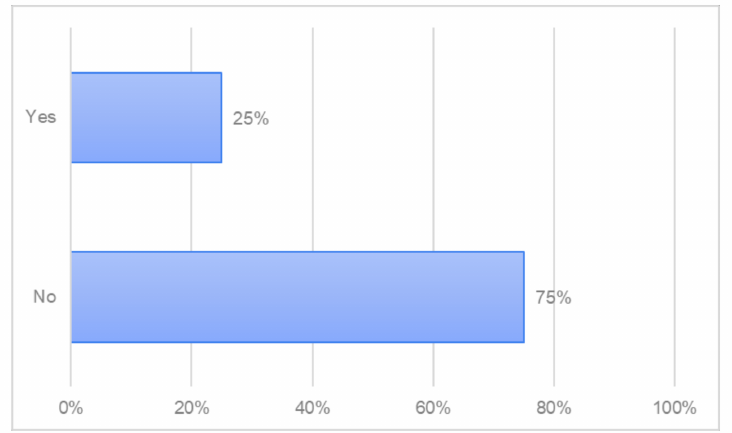
Figure 7. Summary of injuries caused by a power saw at pruning or felling of